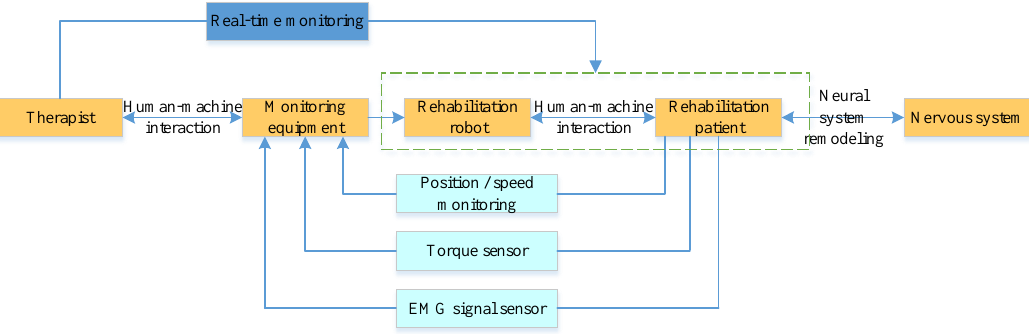
Figure 14. Control system diagram of the exoskeleton.